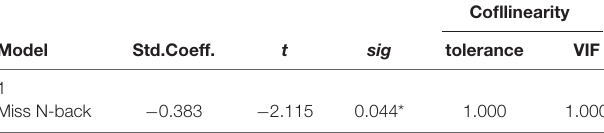
TABLE 7 | Regression coefficient for the model involving miss N-back and mean RR.